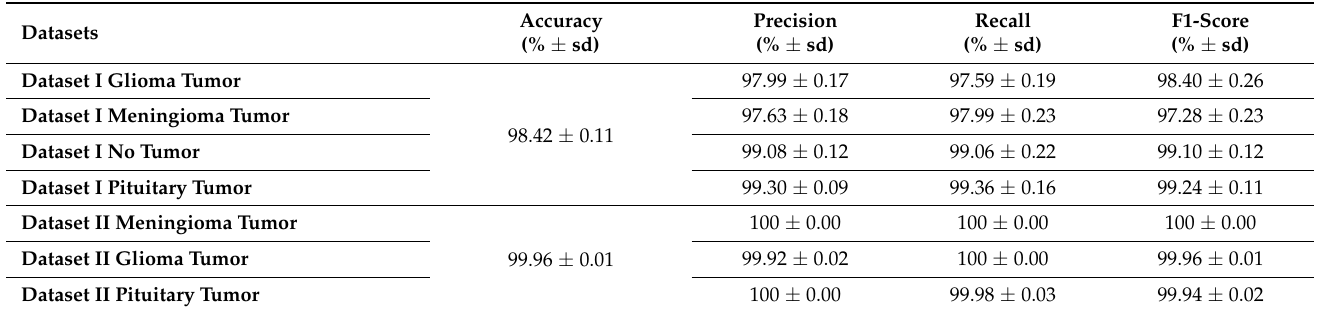
Table 4. Classification metric calculations based on proposed feature extraction and INCA feature selection (%).